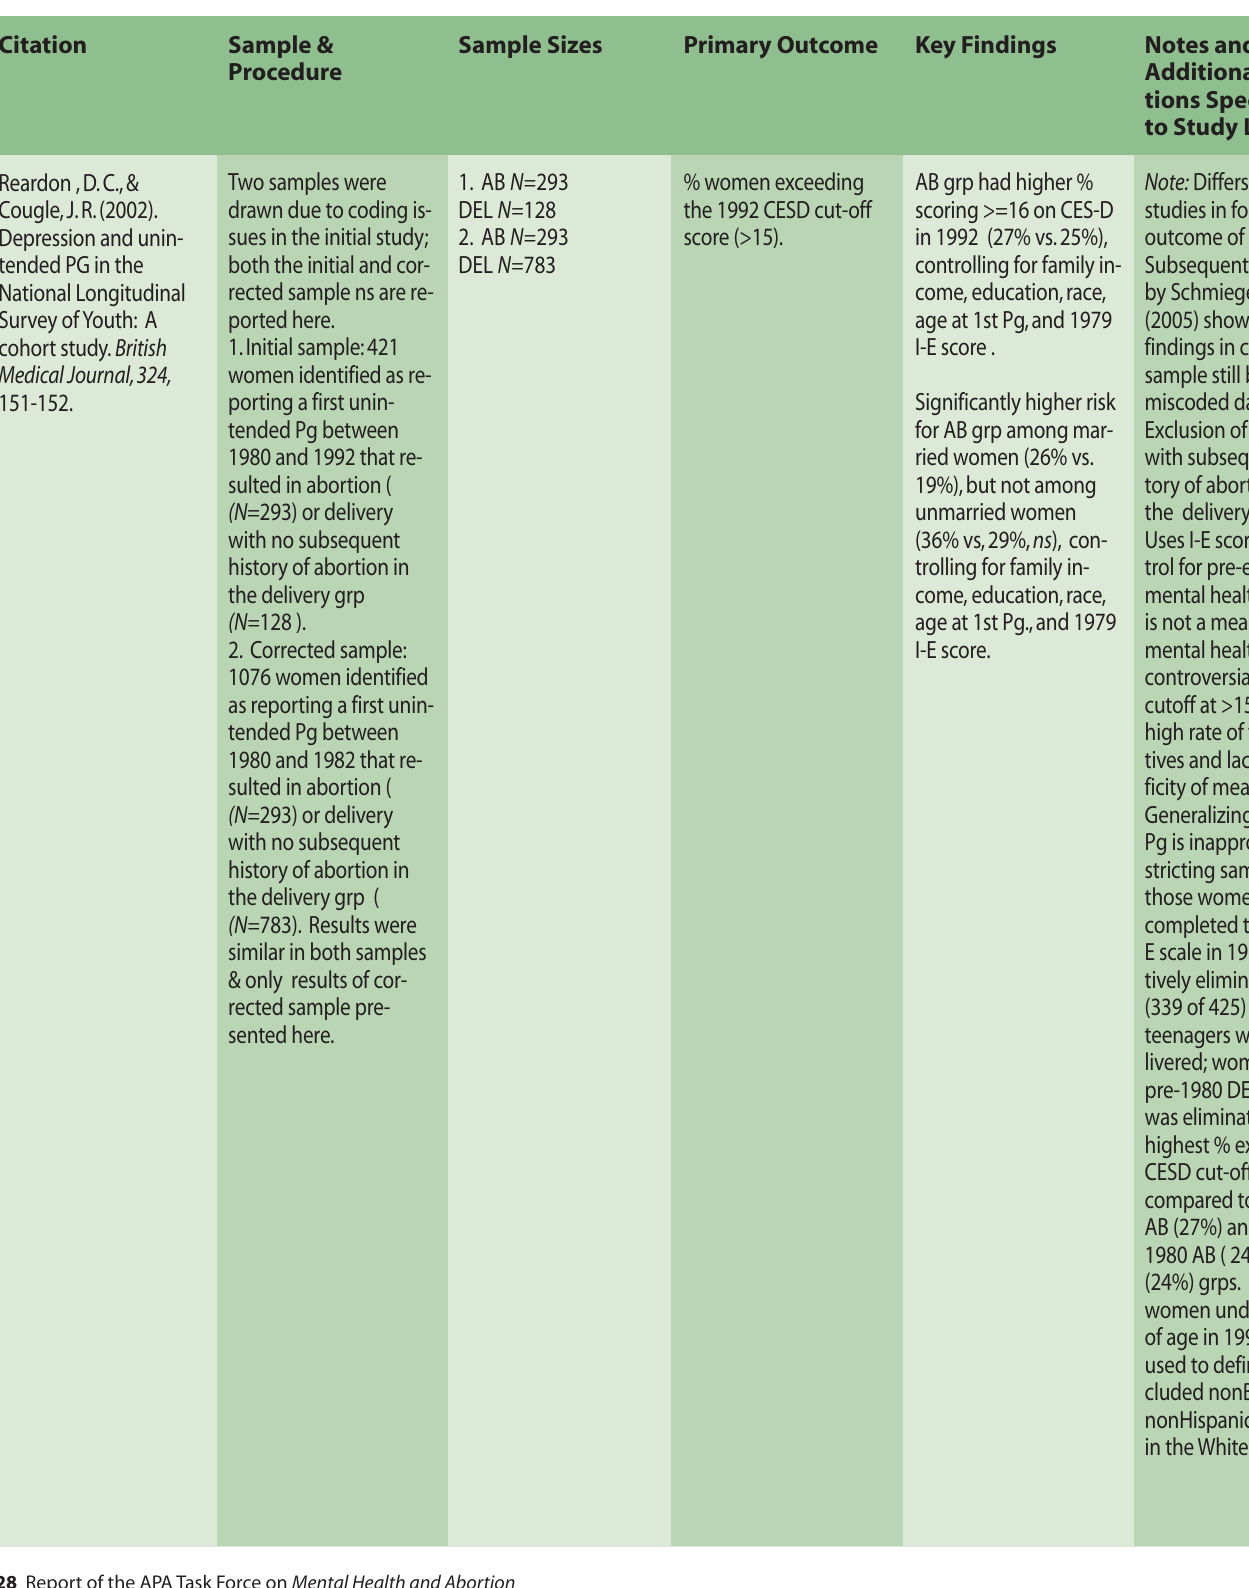
Table 1B: Secondary Analyses of Survey Data–Abortion vs.Comparison Groups U.S.STUDIES